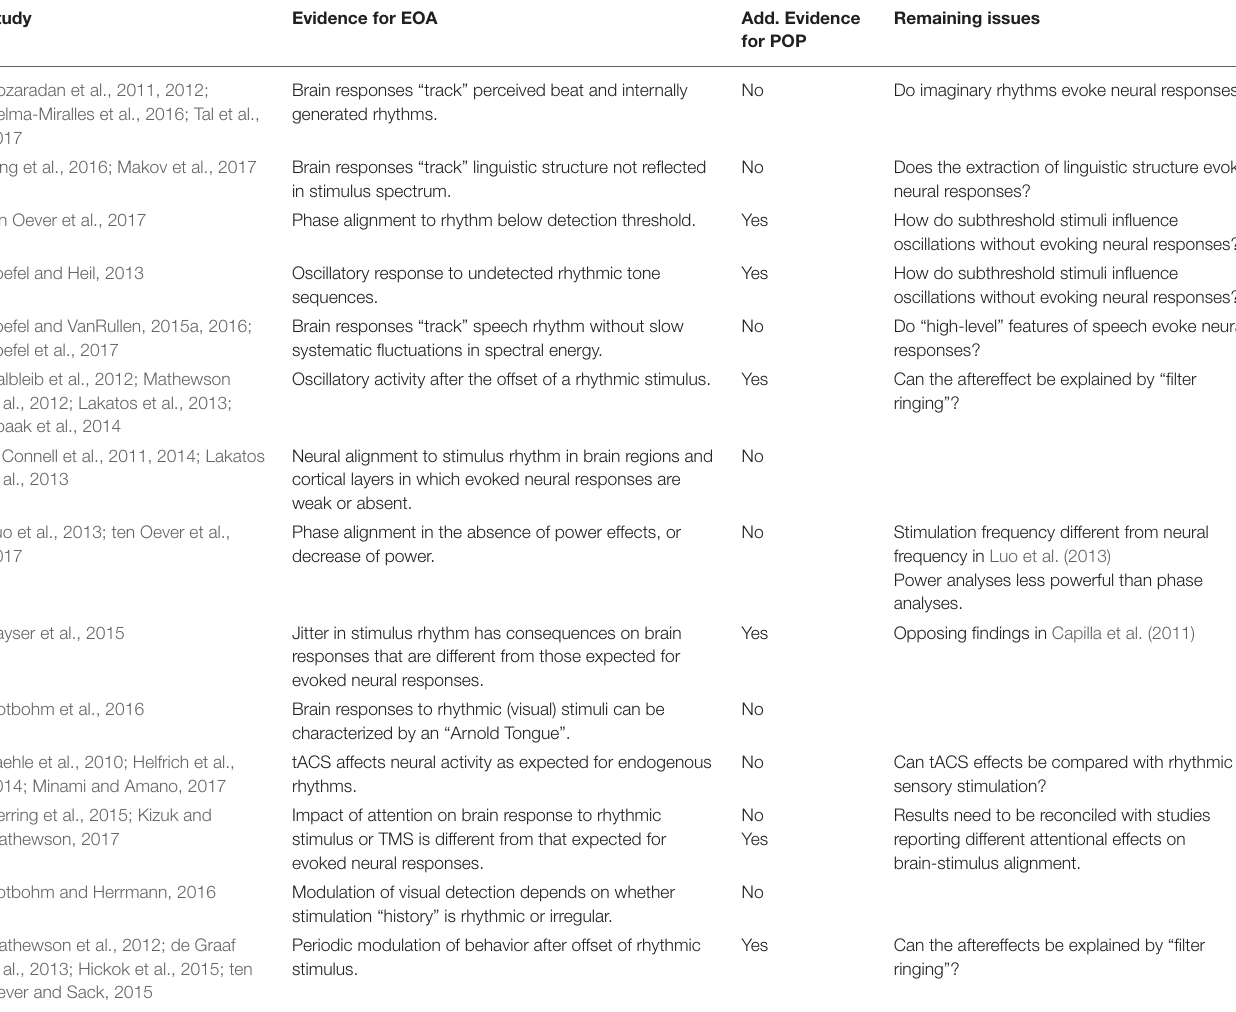
TABLE 1 | Summary of evidence for endogenous oscillatory activity (EOA) and predictive oscillatory processes (POP) involved in the processing of rhythmic stimulus input. Study Evidence for